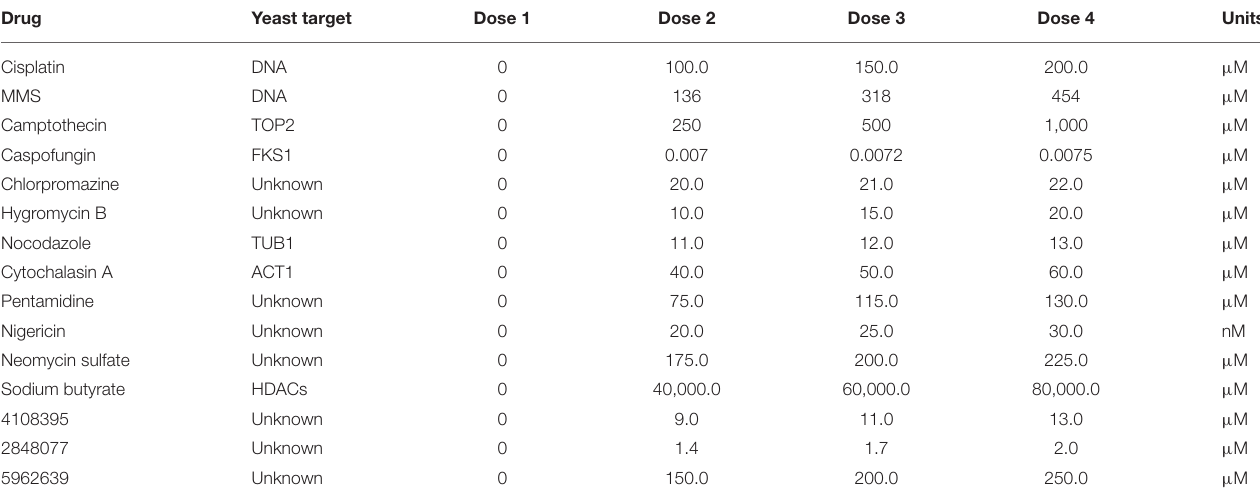
TABLE 3 | Drugs and chemical probes and their concentrations used in a 4-by-4 dose matrix to determine baseline synergy. Drug Yeast target